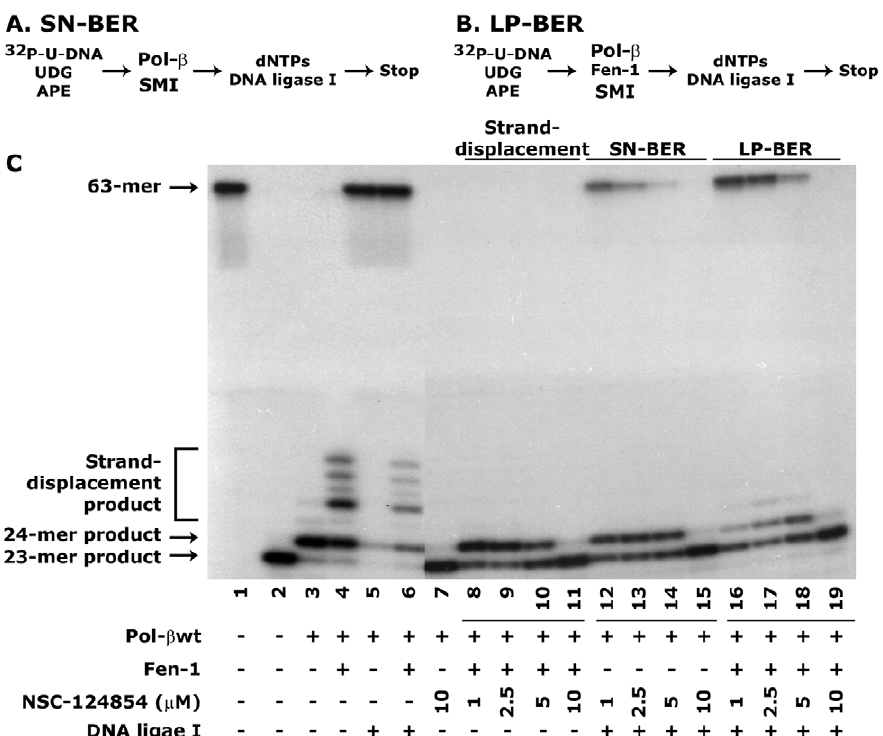
Figure 5. NSC-124854 blocks Pol- b -directed SN- and LP-BER activities. Panels AandB represent the protocols of the SN- and LP-BER, respectively. Panel C shows the autoradiogram describing the effect of varying concentrations of NSC-124854 on SN- and LP-BER activities. Lane 1 shows 63-mer 32 P-labeled U-DNA, Lane 2 shows 23-mer product after APE1 incision, Lane 3 shows 1-nt incorporation by Pol- b , Lane 4 shows strand- displacement products after the addition of Fen1. Lanes 5 and 6 show the 63-mer ligated product of SN- and LP-BER activities, respectively. Lane 8-19 shows the effect of NSC-124854 on the blockage of 1-nt (24-mer product) incorporation. Lanes 8-11 depict NSC-124854-mediated block of strand- displacement synthesis. Furthermore, lanes 12–15 and lanes 16–19 show the effect of NSC-124854 on the blockage of SN- and LP-BER activities in a dose-dependent manner. Data is a representative of three different experiments.